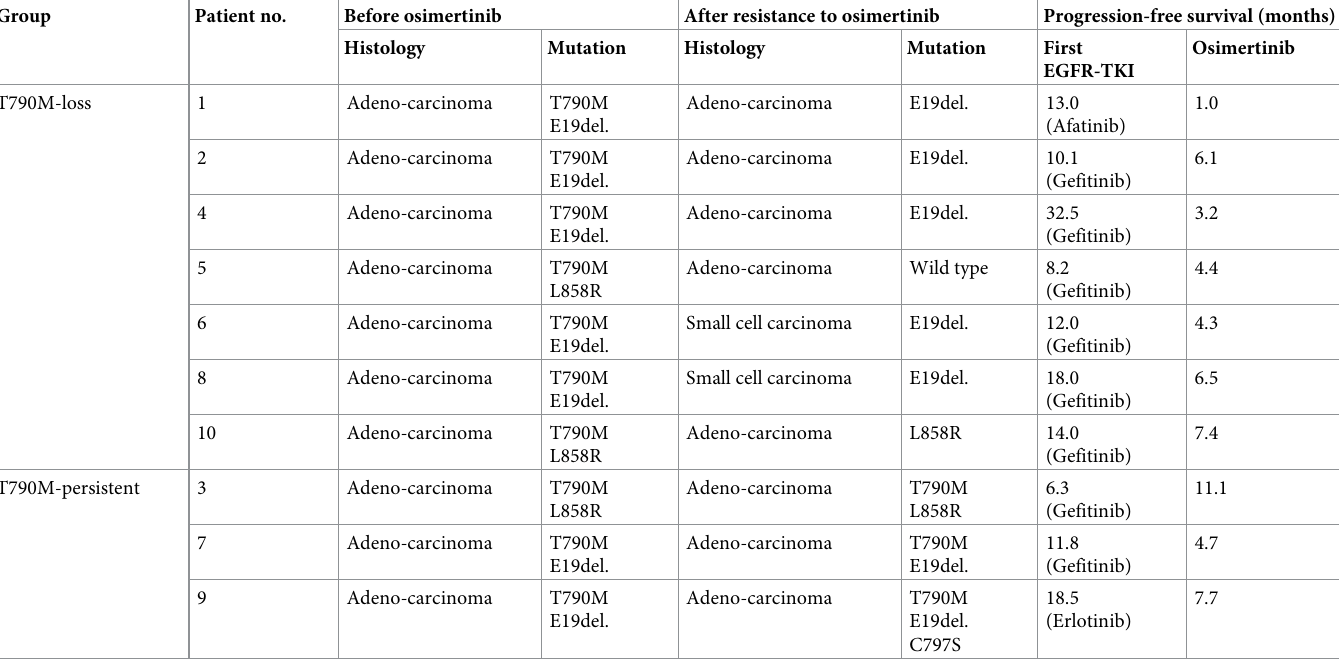
Table 3. Resistance profile of osimertinib in real-world practice. Group Patient